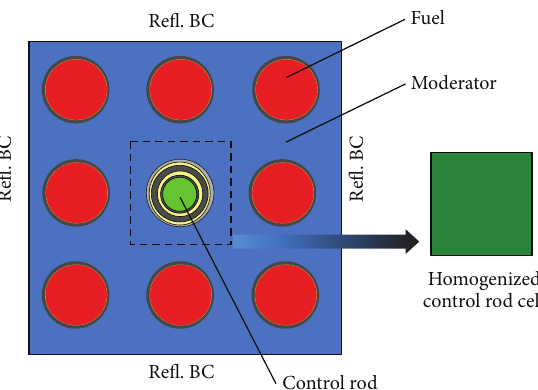
Figure 4: Control rods cross-sections